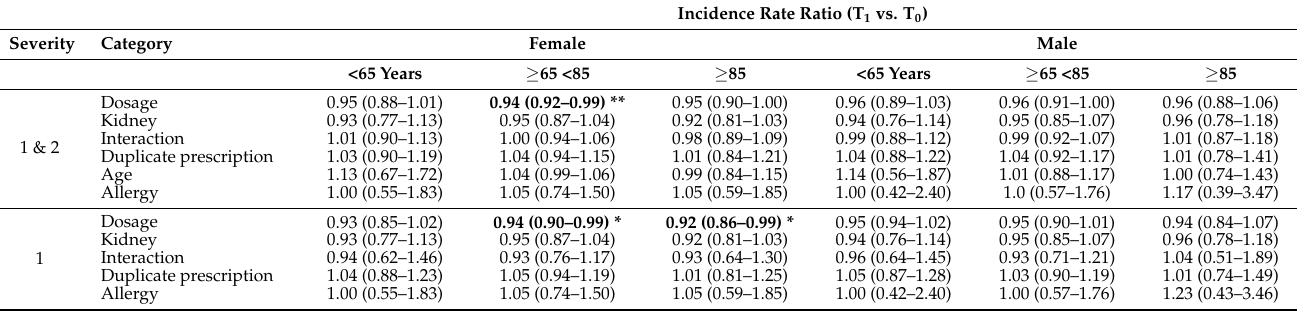
Table 5. Incidence rate ratio of alerts before and after the intervention, stratified by age, sex, alert category, and severity level.